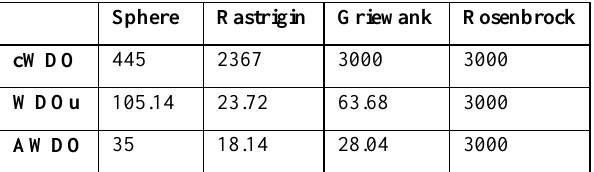
Table 1. Average number of iterations for convergence Sphere